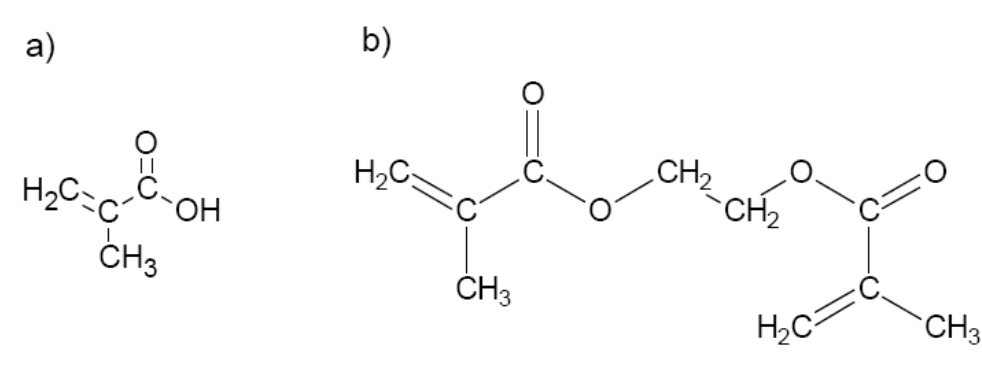
Figure 2. Chemical structures of (a) methacrylic acid and (b) ethylene glycol dimethacrylate